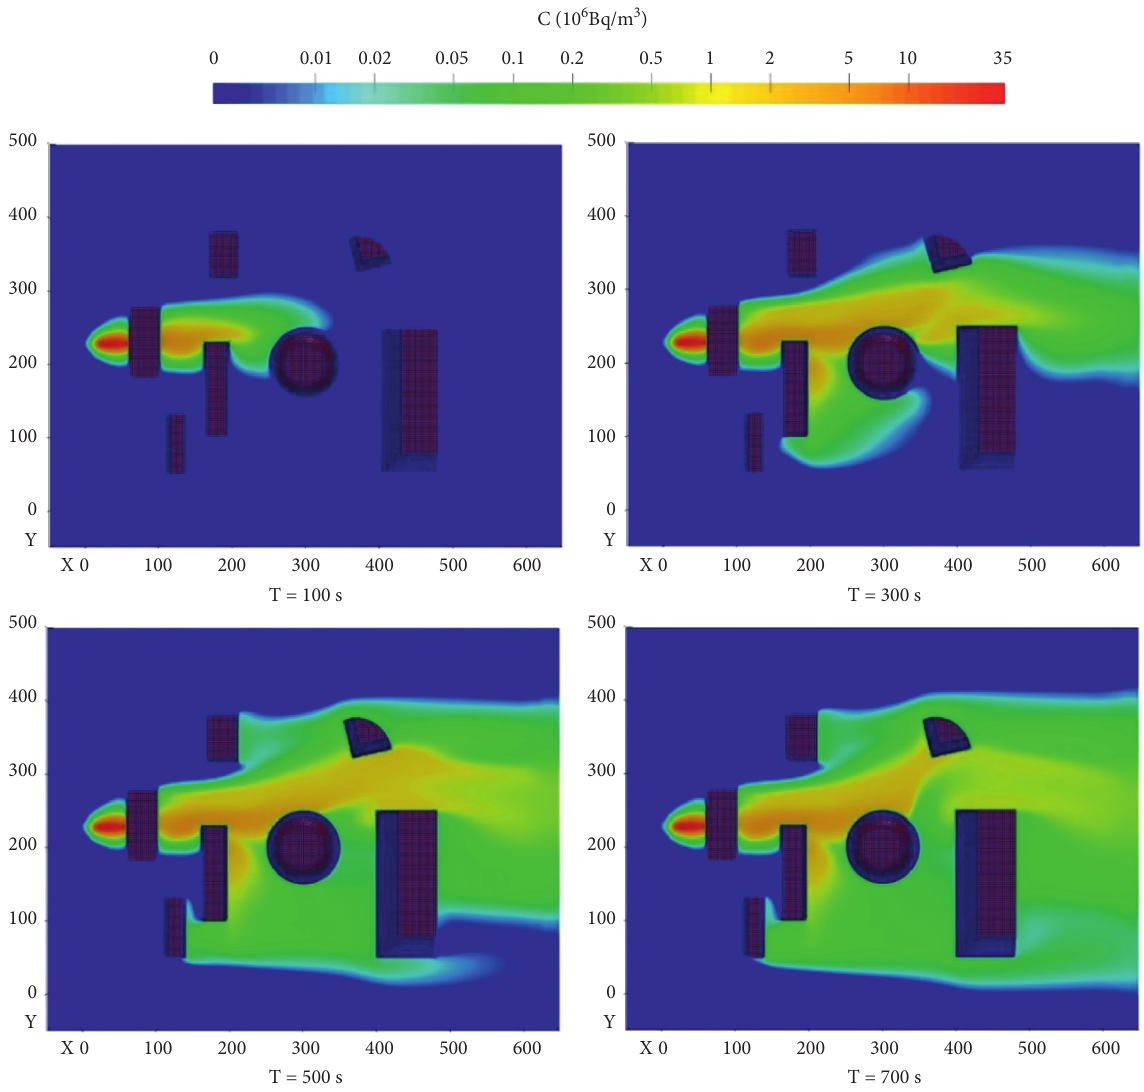
Figure 4: Horizontal distribution of 137Cs concentration at different time (in the XY plane, where z �